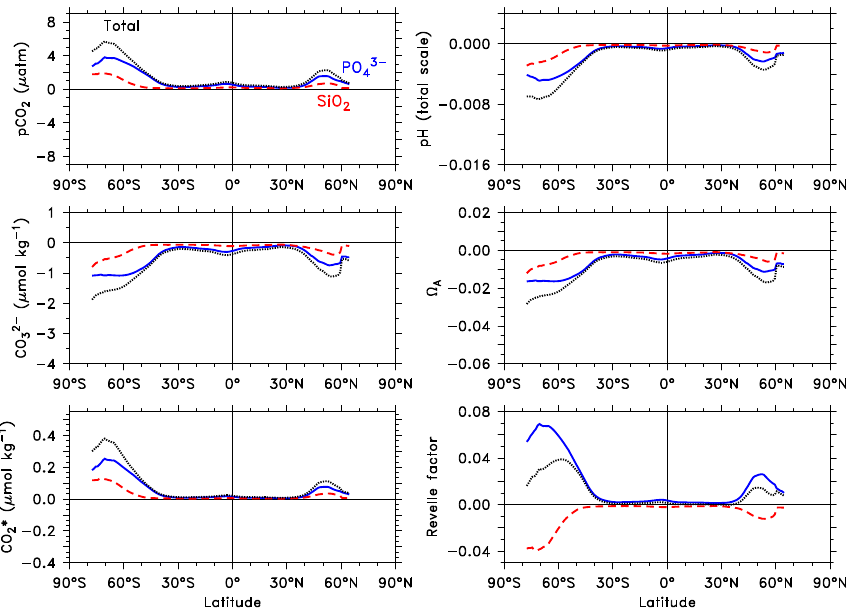
Figure 10. Absolute changes in zonal means of computed variables due to alkalinity contributions from P T (blue solid), Si T (red dashed), and their sum (black dotted) relative to the case where alkalinity from phosphoric and silicic acids is neglected.